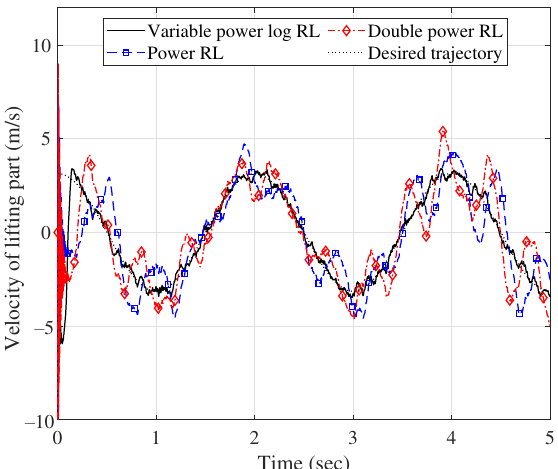
Figure 14. Velocity of lifting part (Group